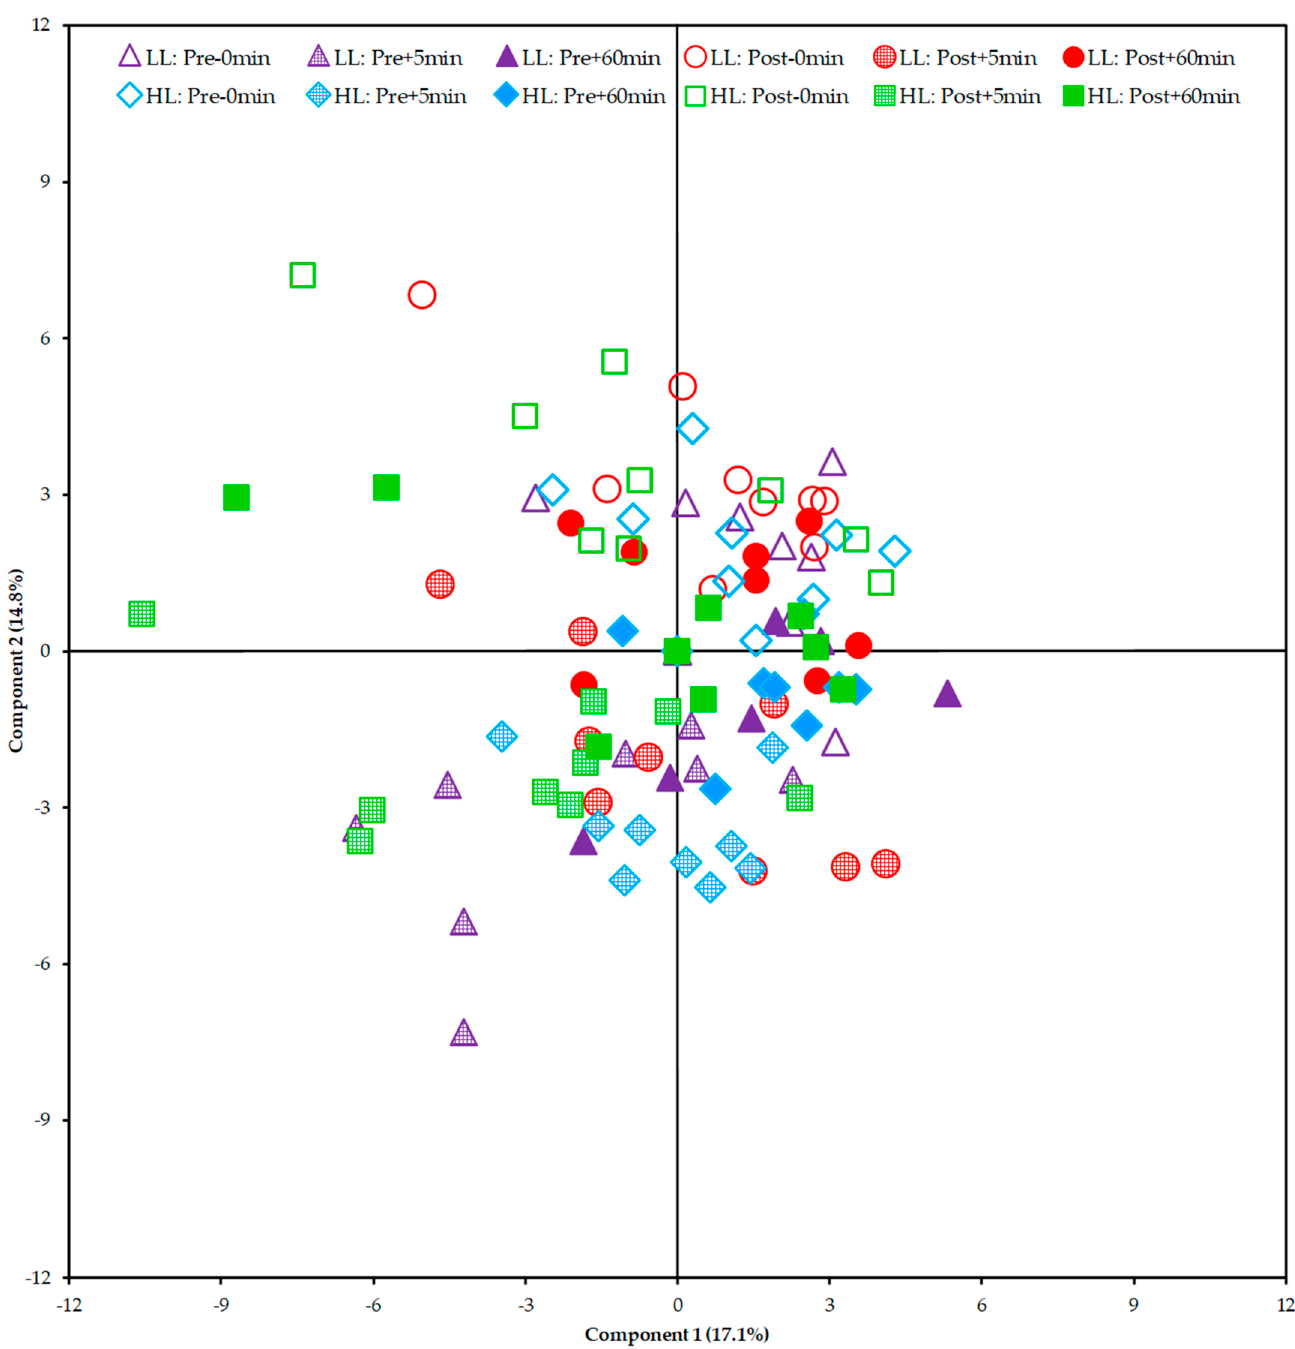
Figure 7. Score plot of the Principal Component Analysis (PCA) including all samples. HL = high-load resistance training; LL = low-load resistance training; Pre = pre-training